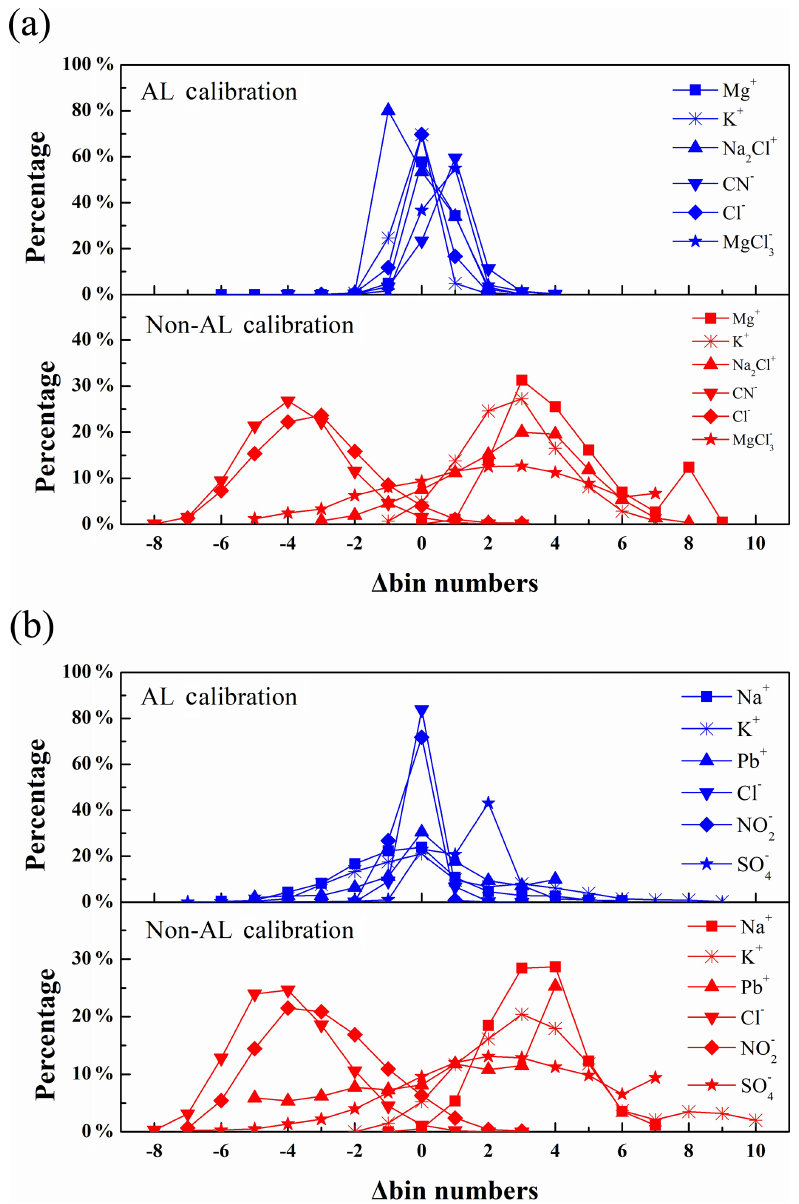
Figure 3. Probability distributions of the marker peak locations before and after automatic linear calibration for (a) sea spray aerosol and (b) ambient